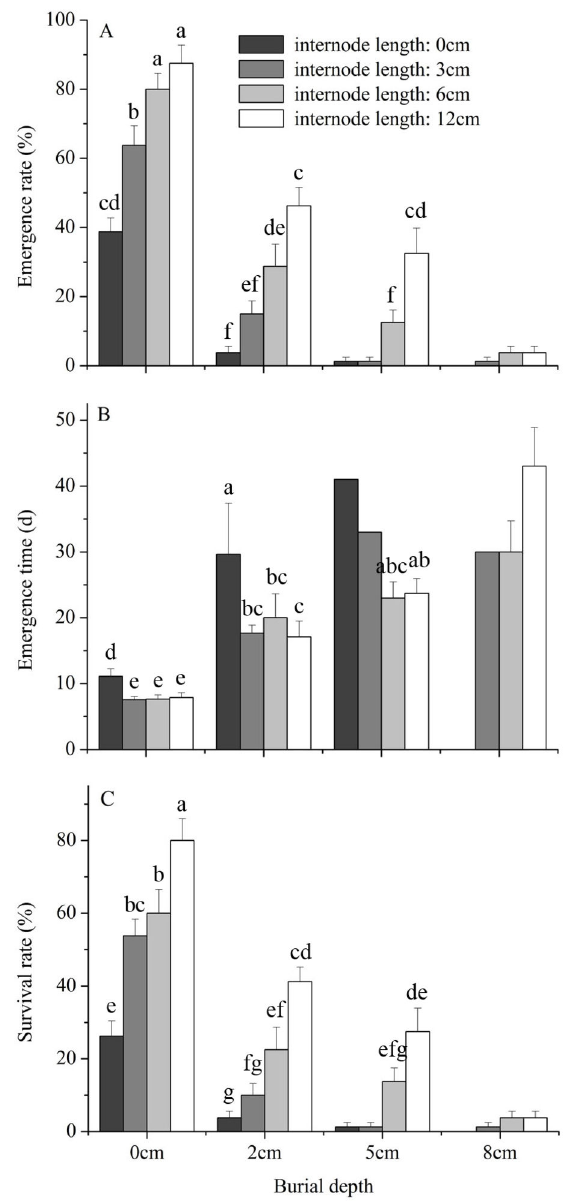
Figure 1. Effects of burial depth and stolon internode length on emergence rate, emergence time and survival rate of Mikania micrantha . Emergence time is the number of days between planting and emergence. Error bars represent the mean ± SE. One-way ANOVAs with post-hoc Duncan’s tests were used for the multiple comparison analyses (data on emergence time were ln- transformed prior to analyses), and significant differences (at the significance level of P =0.05) between two treatments are marked with the use of different